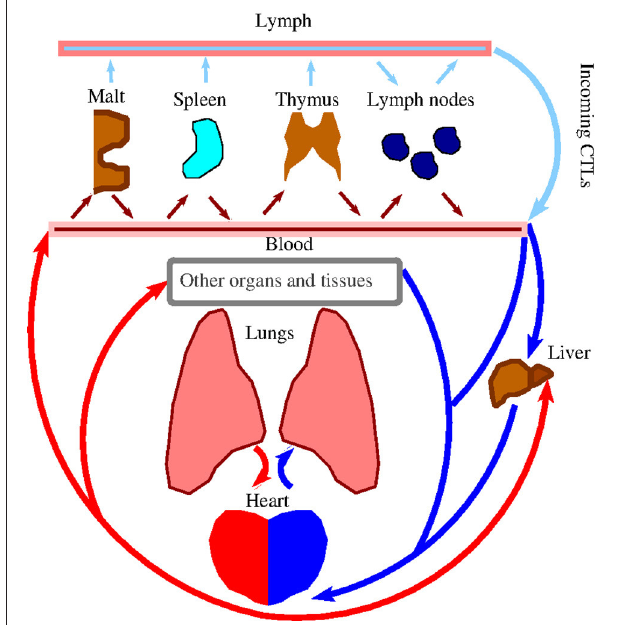
FIGURE 1 | Schematic representation of lymphocyte re-circulation routes. There are two different routes for naïve and activated trafficking lymphocytes ( 12, 13). First, due to the data discussed in Owen et al. (12, Ch.14) and, independently estimated in Van den Berg ( 14, p. 23) after approximately 30 min. transit time in the blood, about 45% of all naïve lymphocytes (produced by the thymus and bone marrow) migrate to the spleen, where they reside for about 5 h. Another 45% of lymphocytes enter various peripheral nodes, where they remain for 12–18 h, scanning stromal cell surfaces. A smaller fraction of lymphocytes migrate to secondary lymphoid tissues (skin, gastrintestinal, etc.), to protect the organism against the external environment. Thus, about 5% of the lymphocytes are, at resting conditions, in the blood, and the majority resides in the lymph nodes. Second, as discussed in Poleszczuk et al. ( 15) activated CTLs enter the blood system via the great veins, flow through the pulmonary circulation, and, then, continue into systemic circulation. Venus blood from gastrointestinal tract and spleen goes to the liver through the hepatic portal vein. In all cases, lymphocytes migrate from the blood into lymph nodes through high-endothelial venues, specialized areas in postcappillary venues. (a) MALT is Mucosa Associated Lymphoid Tissue. (b) Lymph nodes have both afferent and efferent lymphatic vessels, while MALT, Spleen, and Thymus have efferent lymphatic only (